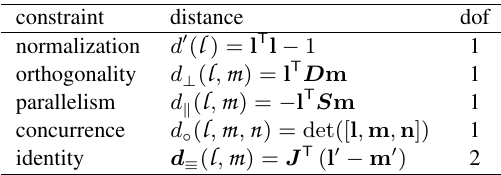
Table 1. Distance measures for three straight lines l , m , and n with corresponding degrees of freedom (dof). The normalization d (cid:48) ( l ) to unit length ensures unambiguous adjustment results. formulation of the constraints, we apply the diagonal matrix D